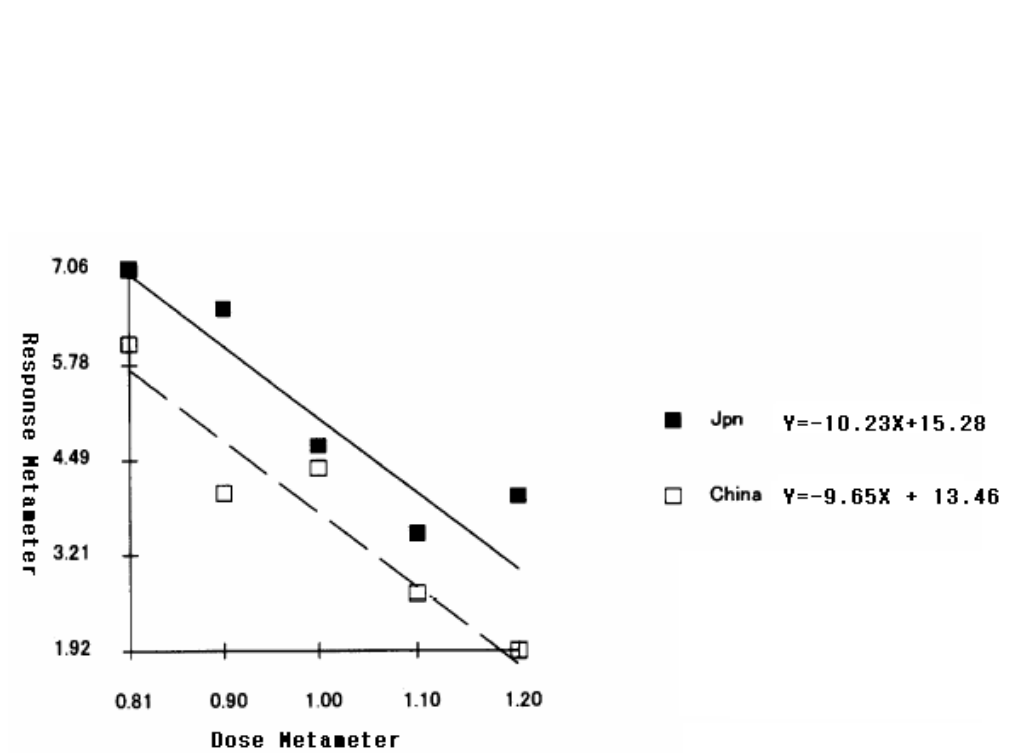
Figure 1: Median anti-lethal toxin effective dose (ED Jiangzhe Agkistrodon halys (China) antivenoms against 115.4 µg Agkistrodon halys venom (4 x LD ) intravenously administered to 50